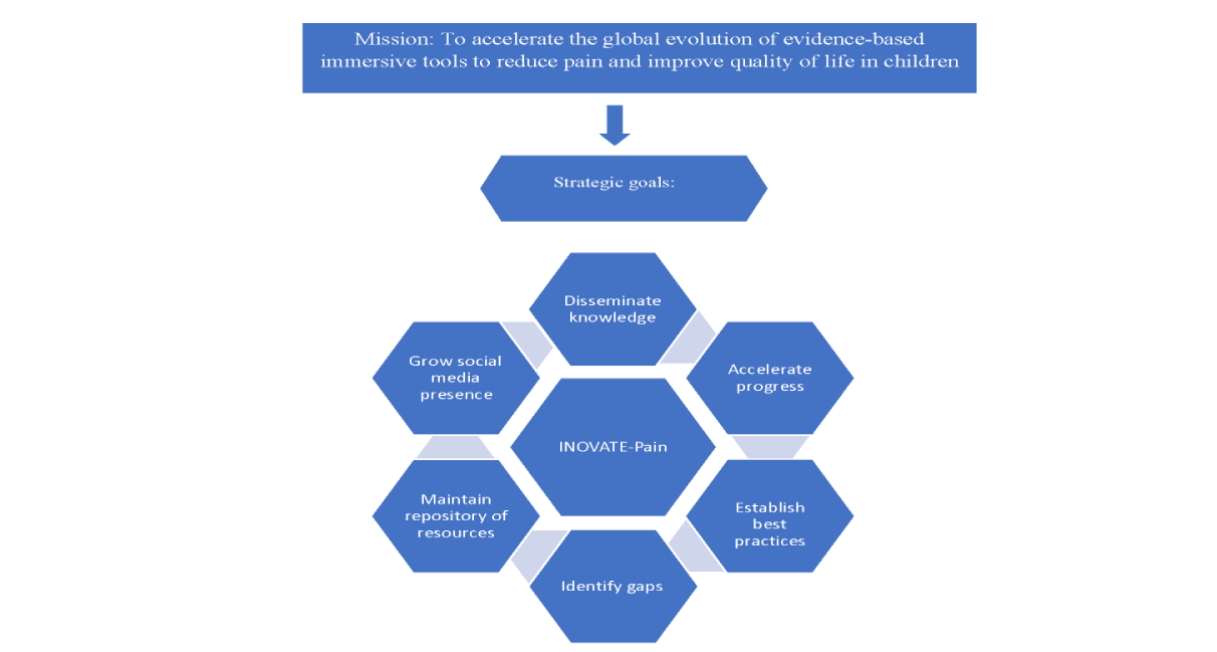
Figure 2. Mission and strategic goals of the INOVATE-Pain (Interdisciplinary Network on Virtual and Augmented Technologies for Pain management)